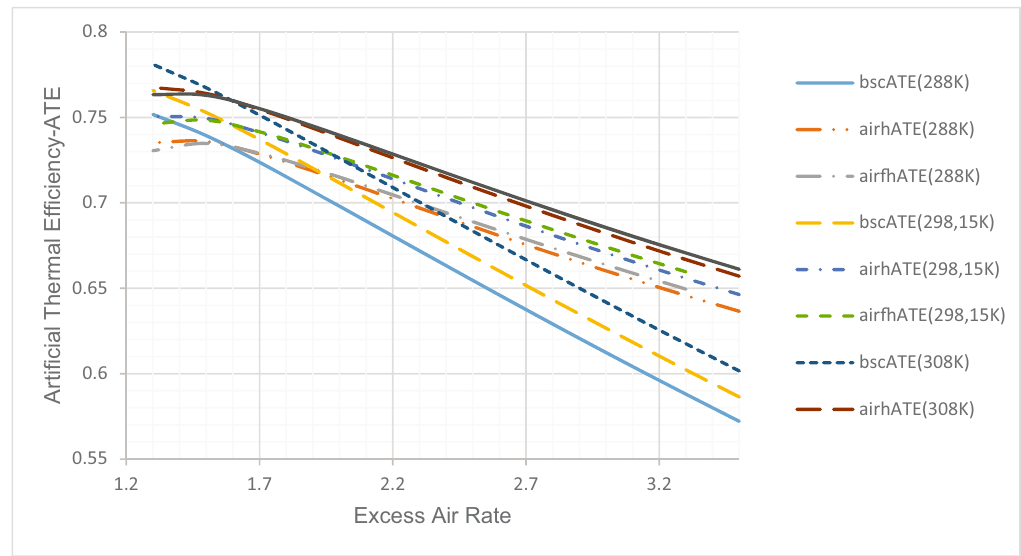
Figure 10: Variation of arti fi cial thermal e ffi ciency with air excess coe ffi cient at di ff erent compressor inlet air temperatures for basic ( bsc ) , absorption cooling ( ab ) , air ( airh ) , and air fuel ( airfh ) heating cogeneration cycles ( m fuel = 1.64 kg/h, η isC = η isT = 0.86, r = 10, T recout = 850 K, T = 485.57 K, and T = 426 K ) . steam Exh